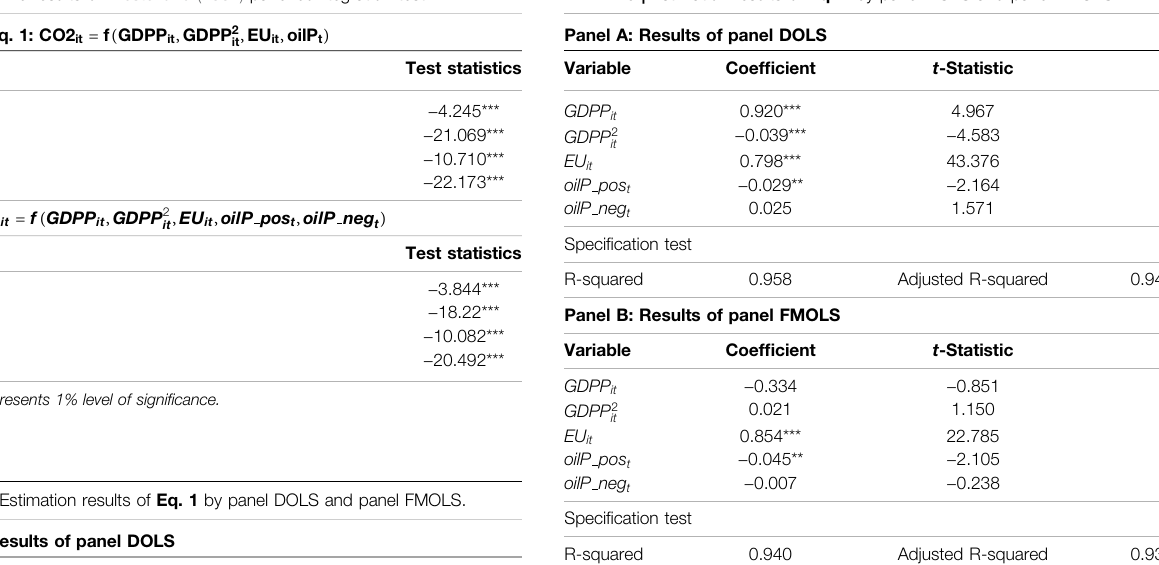
TABLE 6 | Estimation results of Eq. 1 by panel DOLS and panel FMOLS. TABLE 4 | The results of Westerlund (2007) panel cointegration test.